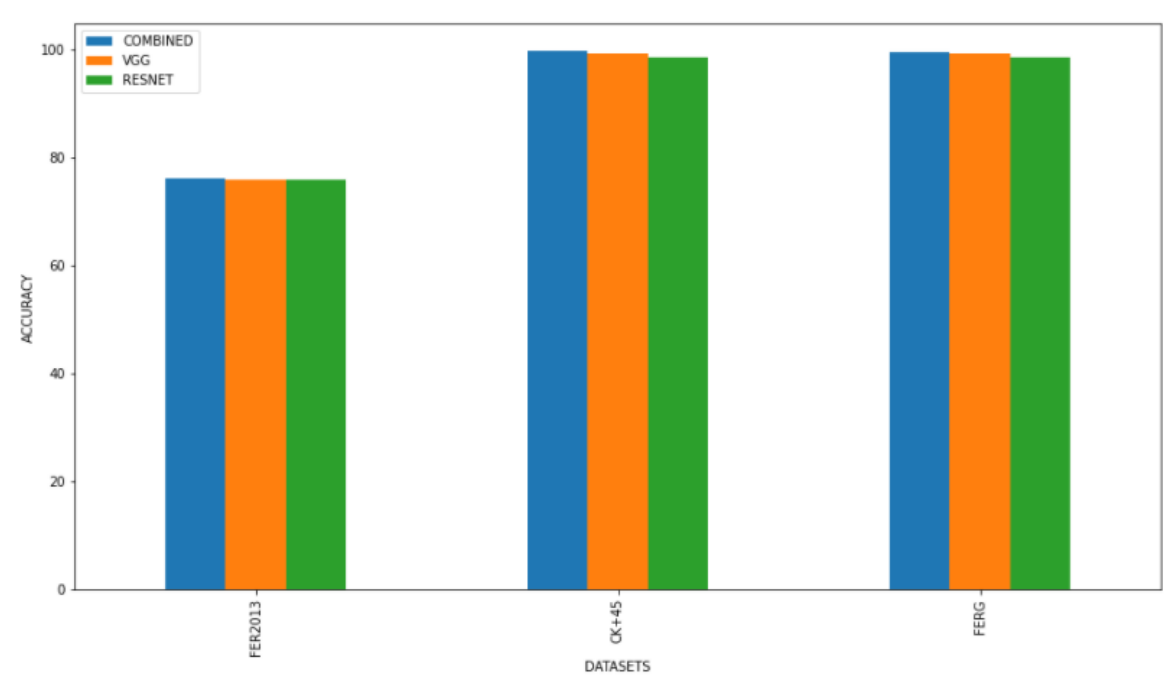
Figure 7. Accuracy comparison based on the model used for transfer learning.